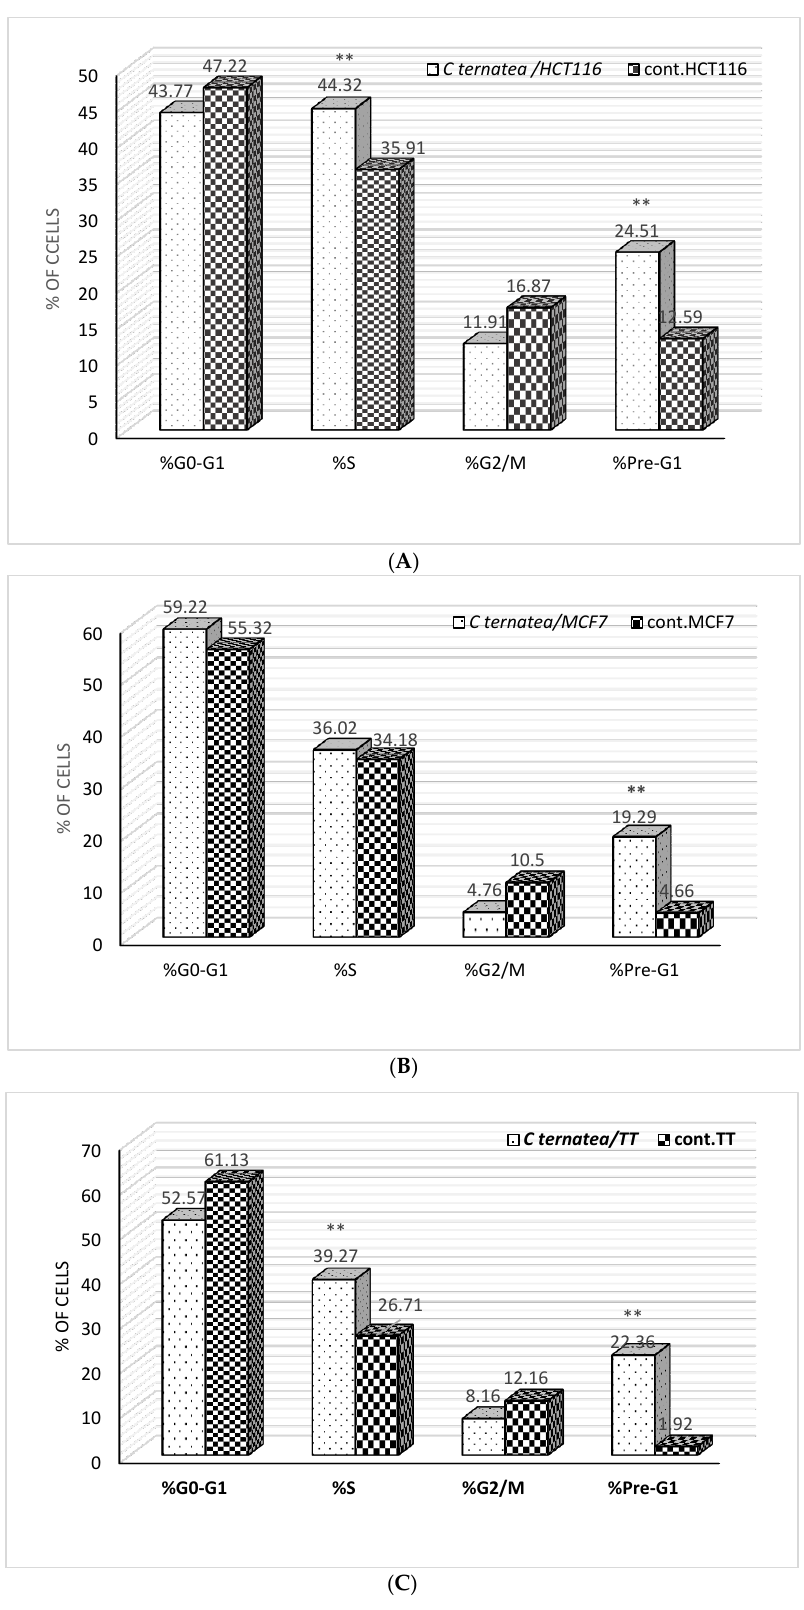
Figure 5. Cell cycle analysis of HCT116, MCF-7, and TT cells after treatment by IC50 of C. ternatea extract relative to the untreated control ( C ). ( A ) HCT116, ( B ) MCF-7, and ( C ) TT cell lines. ** p -value < 0.01 represent highly significant statistical differences.